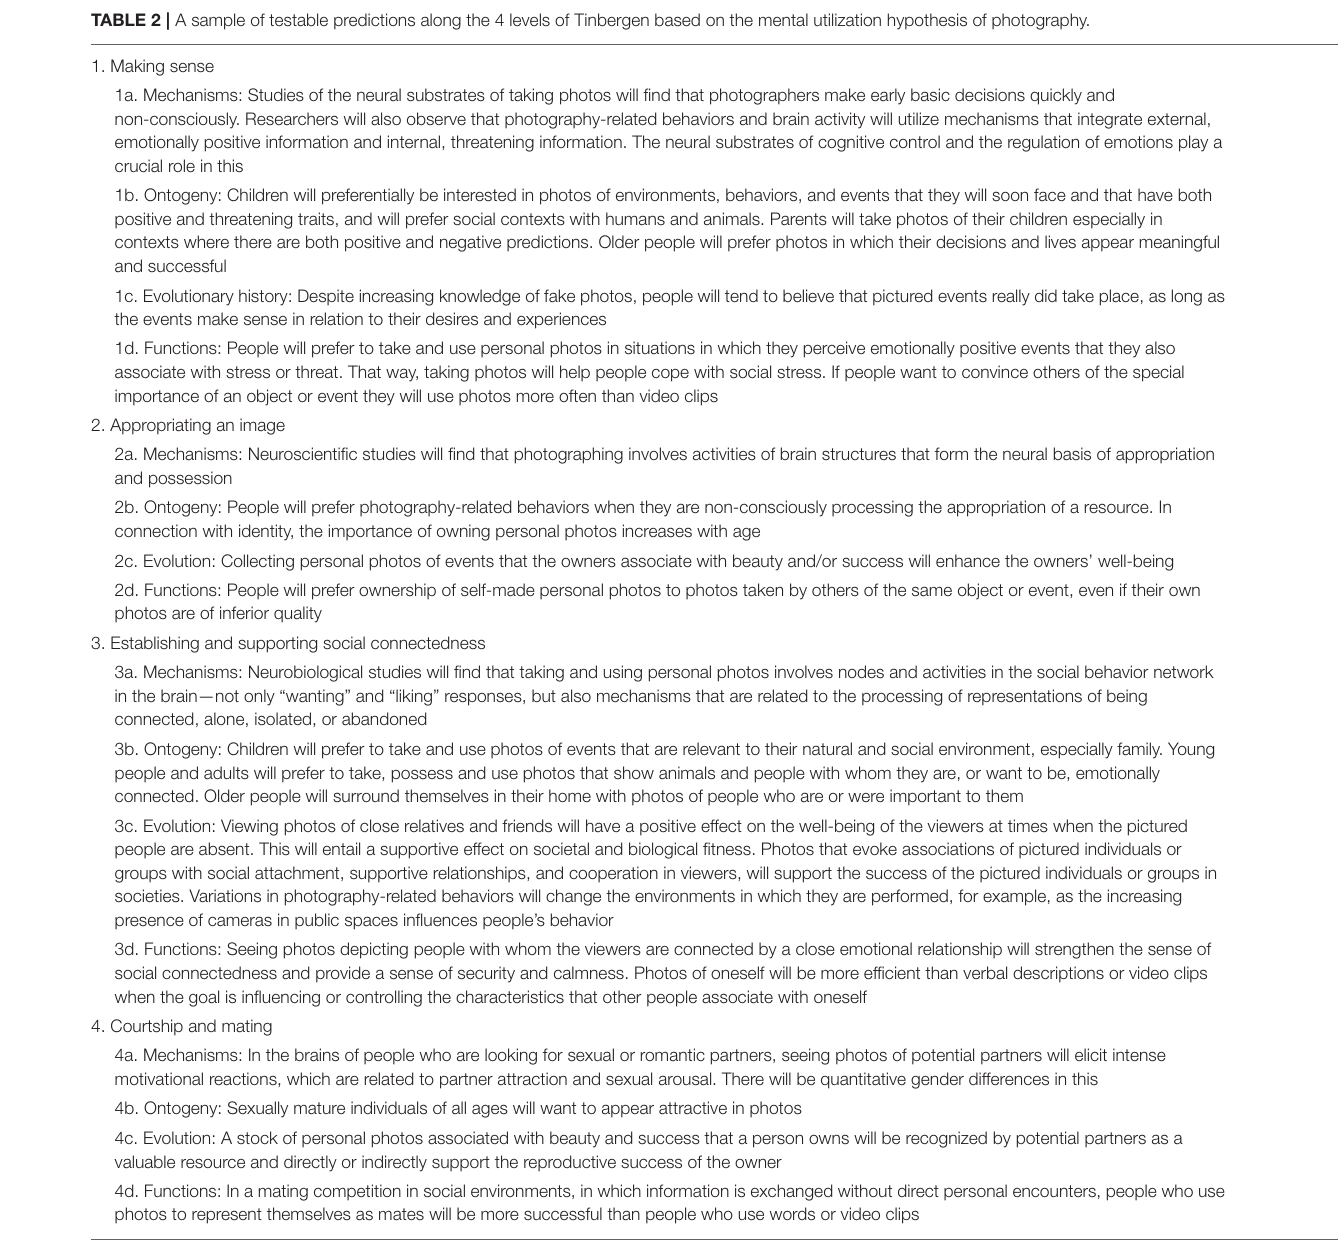
TABLE 2 | A sample of testable predictions along the 4 levels of Tinbergen based on the mental utilization hypothesis of photography. 1. Making